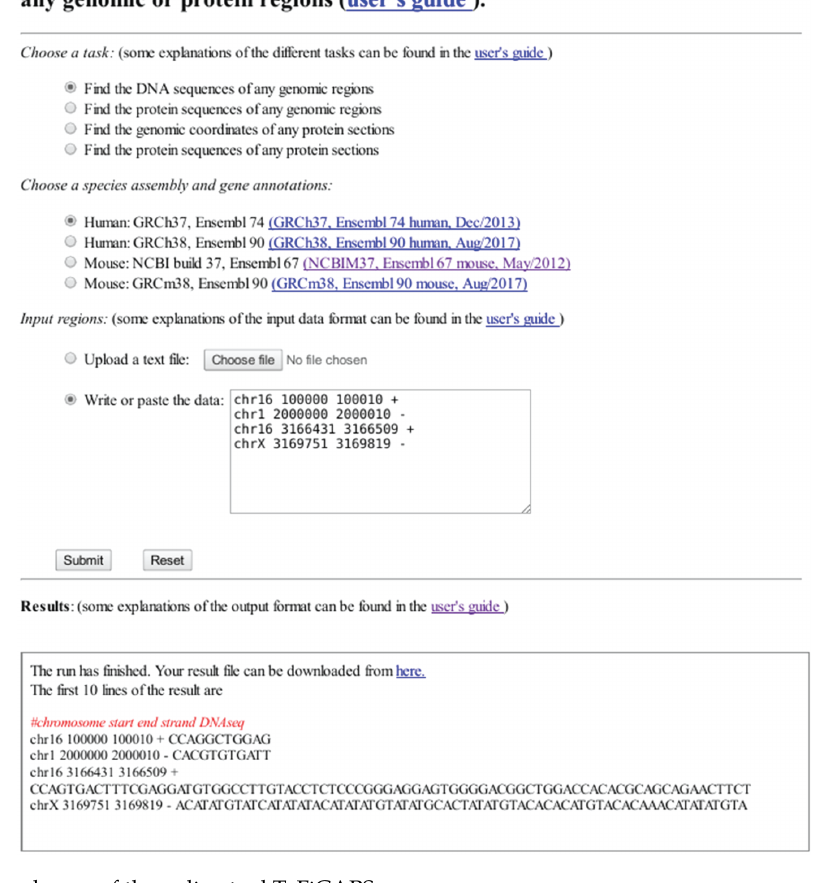
Figure 2: The main webpage of the online tool